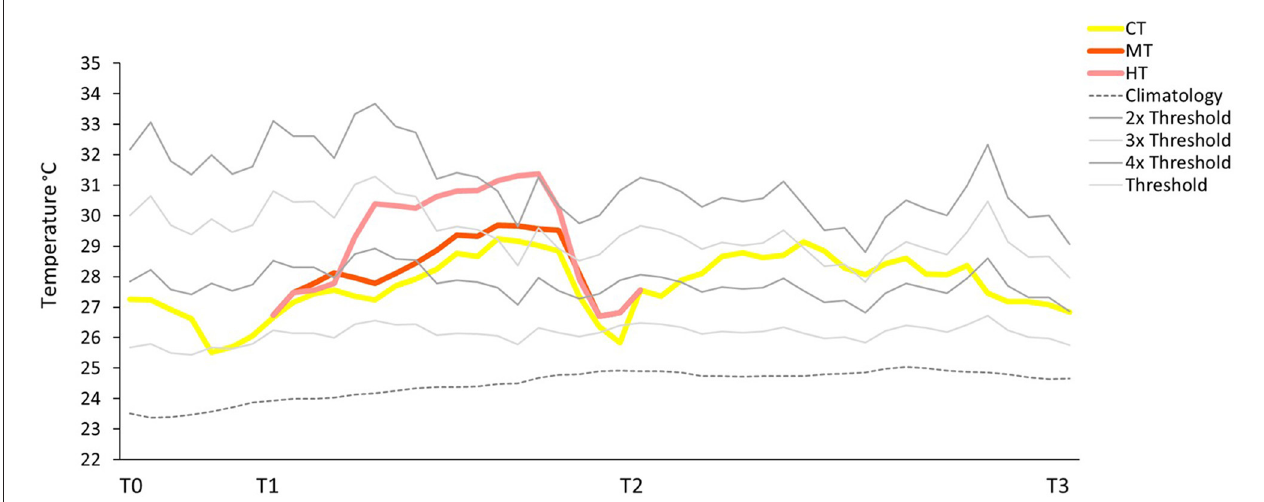
FIGURE 6 | Future MHWs. Temporal variation of temperature at the common garden at the CT, MT, and HT area. T0, T2, and T3 refer to the sampling times. T1 refers to the time the shoots were moved to the different temperature areas. Climatology was calculated based on the last 30 years of SST; Threshold represents the 90